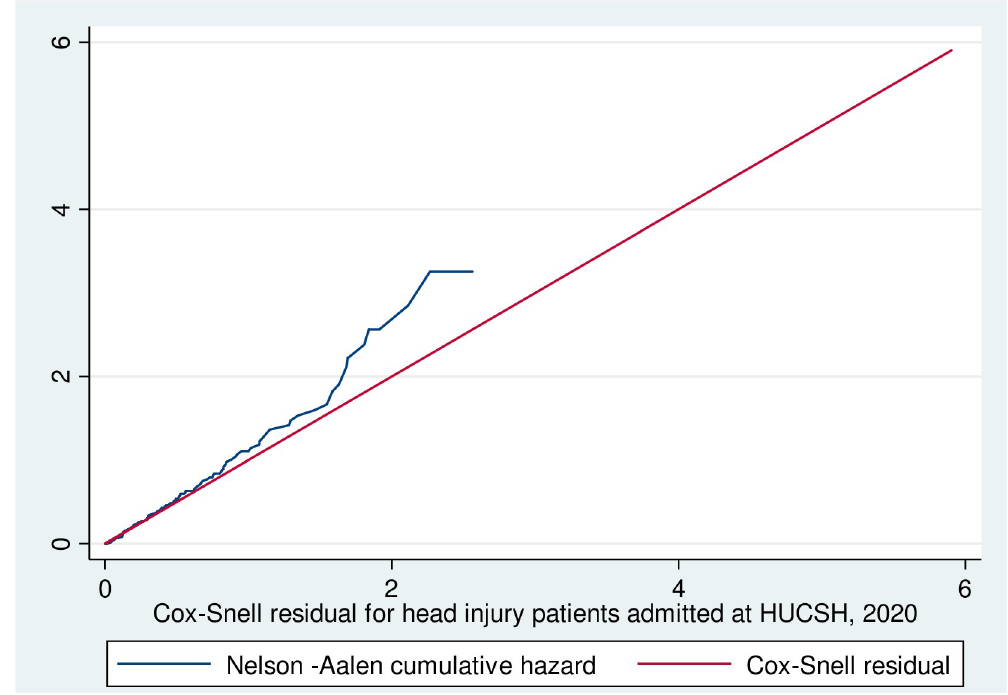
Fig 4. Nelson-Aalen cumulative hazard graph against Cox-Snell residual on head injury patients at HUCSH, 2020.